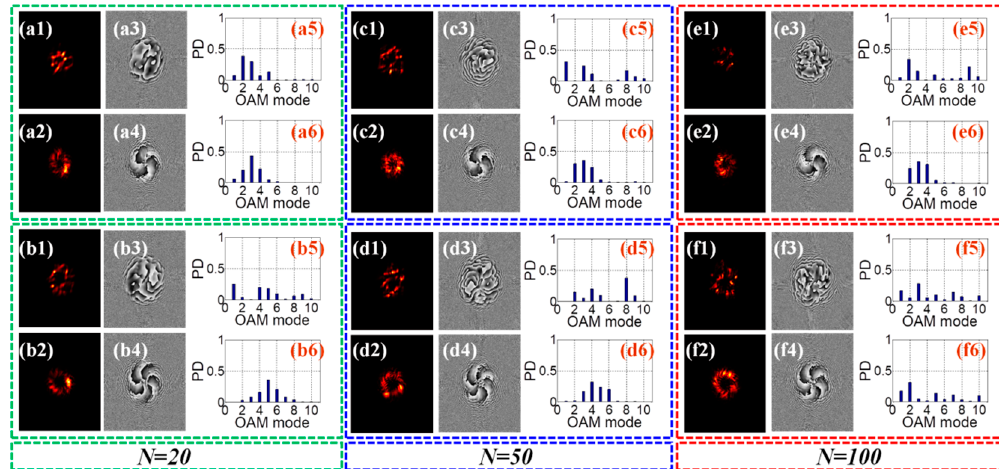
Figure 5. The intensity and phase distributions of OAM beams and their PD spectra without and with the pre-compensation of GS algorithm under simulated atmospheric turbulence with refractive-index structure parameter C 2 n valued as 1 × 10 − 13 m − 2/3 . The parts framed in green, blue and red dashes represent random phase screens number N = 20, 50 and 100 respectively. (a1, c1, e1) and (b1, d1, f1) are intensity profiles without pre-compensation for topological charge l = 3 and l = 5 respectively, (a3, c3, e3) and (b3, d3, f3) are their corresponding phase, (a5, c5, e5) and (b5, d5, f5) are their corresponding PD spectra; (a2, c2, e2) and (b2, d2, f2) are intensity profiles with the pre-compensation of GS algorithm for l = 3 and l = 5 respectively, (a4, c4, e4) and (b4, d4, f4) demonstrate their corresponding phase distributions, (a6, c6, e6) and (b6, d6, f6) are their corresponding PD spectra accordingly.